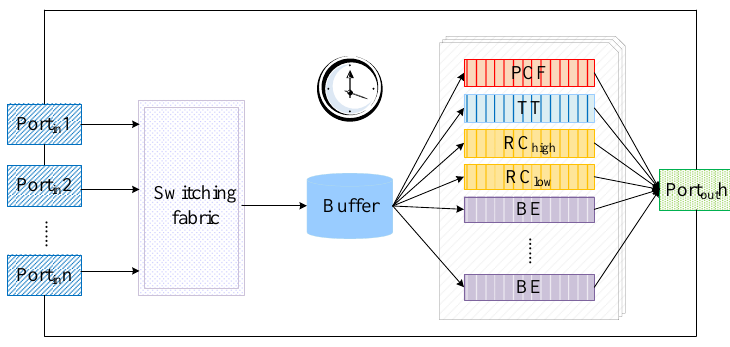
Figure 1. TTEthernet switch architecture.